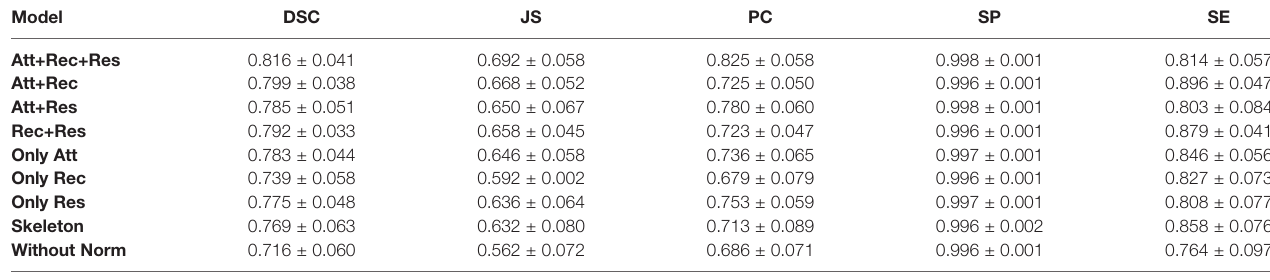
TABLE 2 | The ablation analysis validates the effectiveness of our model ’ s con fi guration.